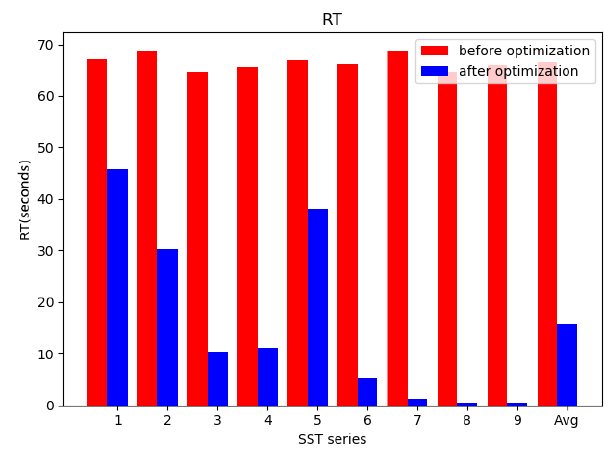
Figure 7. Comparison of RT before and after optimization.